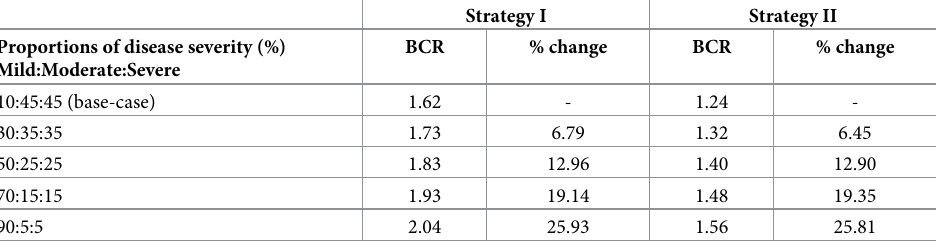
BCR: Benefit-cost